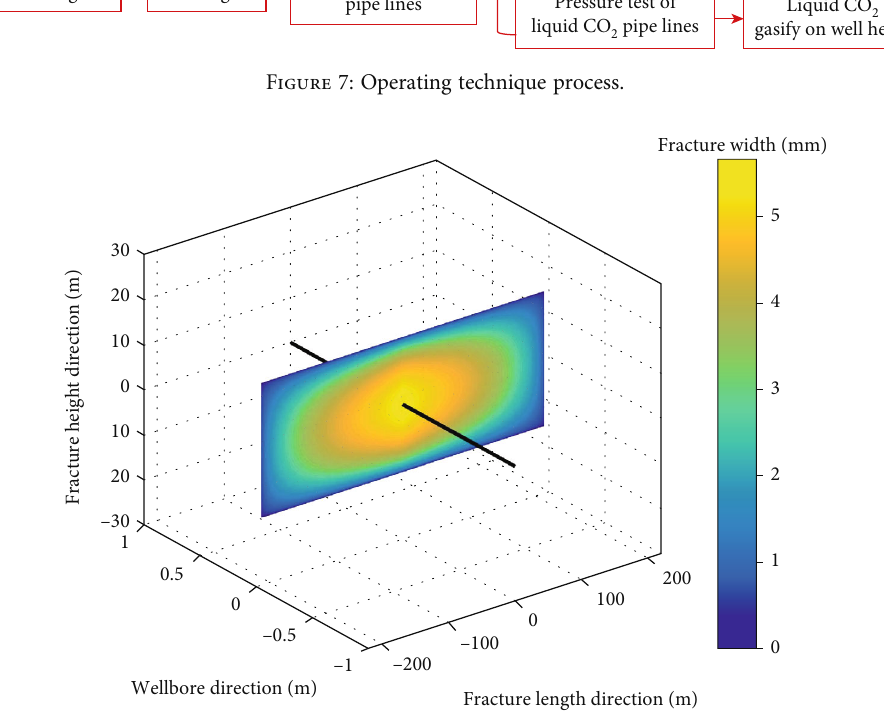
Figure 8: Fracture morphology of carbon dioxide foam fracturing (displacement 4.0m 3